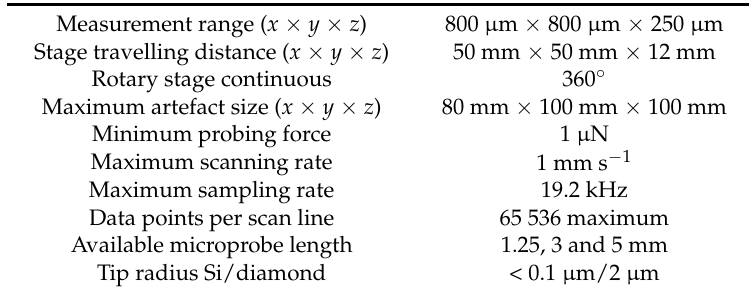
Table 3. Specifications of PTB’s Profilescanner for the traceable measurement of high aspect microstructures.